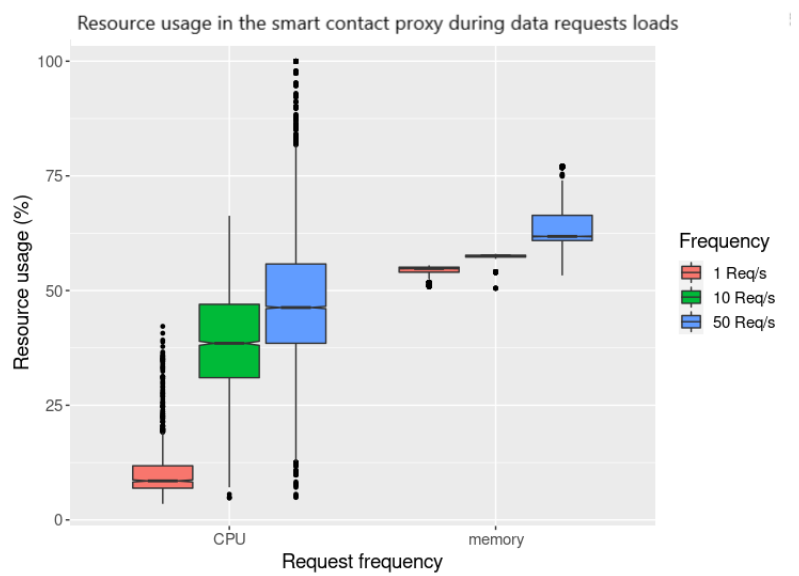
Figure 10. Resource consumption measured in the smart contract proxy with mean